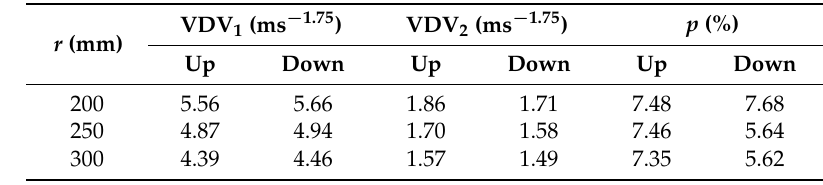
Table 5. The calculated results of the vibration responses.